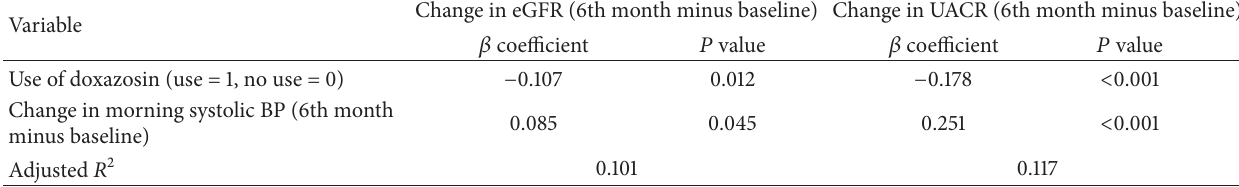
Table 3: Factors associated with change in eGFR and UACR.